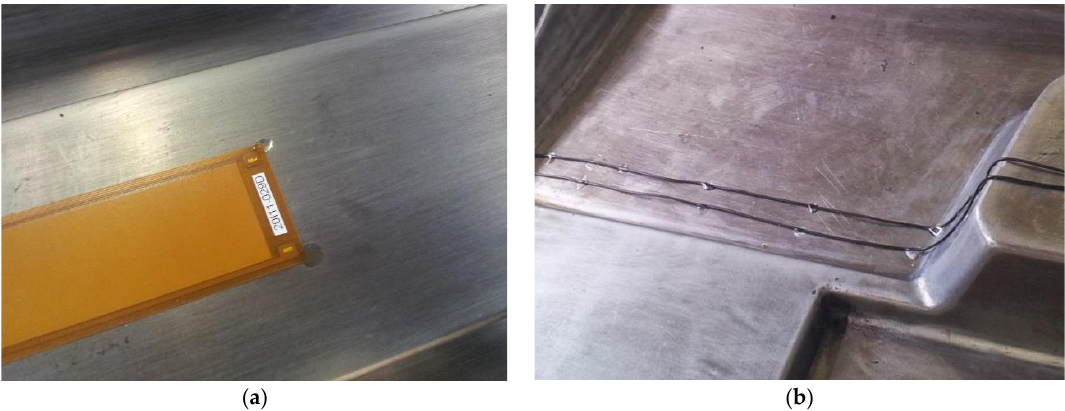
Figure 9. ( a ) Local fixation of the piezoelectric actuator, and ( b ) connecting cables in the mold cavity by means of a fast curing adhesive.